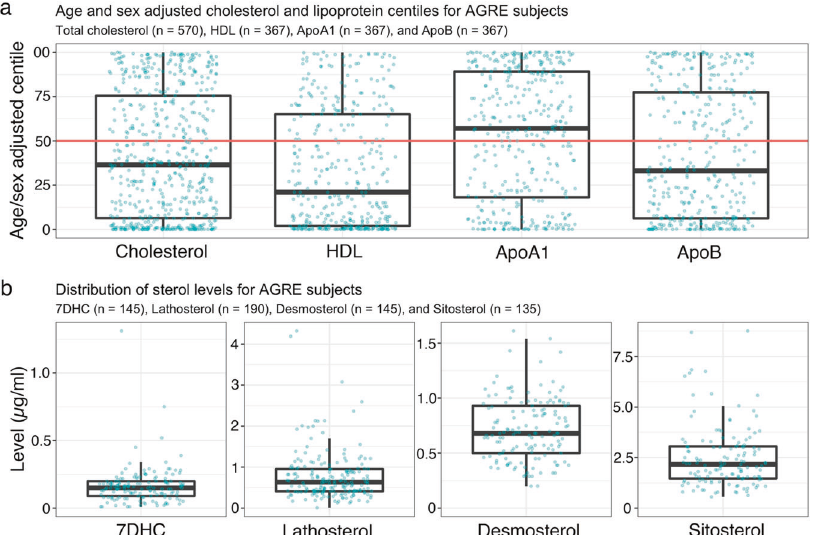
Fig. 4 Distributions of AGRE cholesterol and lipoprotein centiles and sterol levels. a Distribution of cholesterol ( n = 570), high-density lipoprotein cholesterol (HDL) ( n = 367), apolipoprotein A1 (ApoA1) ( n = 367), and apolipoprotein B (ApoB) ( n = 367) centiles for AGRE subjects. b Distribution of 7-dehydrocholesterol (7DHC) ( n = 145), lathosterol ( n = 190), desmosterol ( n = 145), and sitosterol ( n = 135) blood levels. Points represent values for individual AGRE subjects. For the boxplots: centerline is median, edges of box are upper and lower quartiles, whiskers extend to 1.5 times the interquartile range from the edge of the box. Points above and below the whiskers represent outliers. Red line indicates 50th